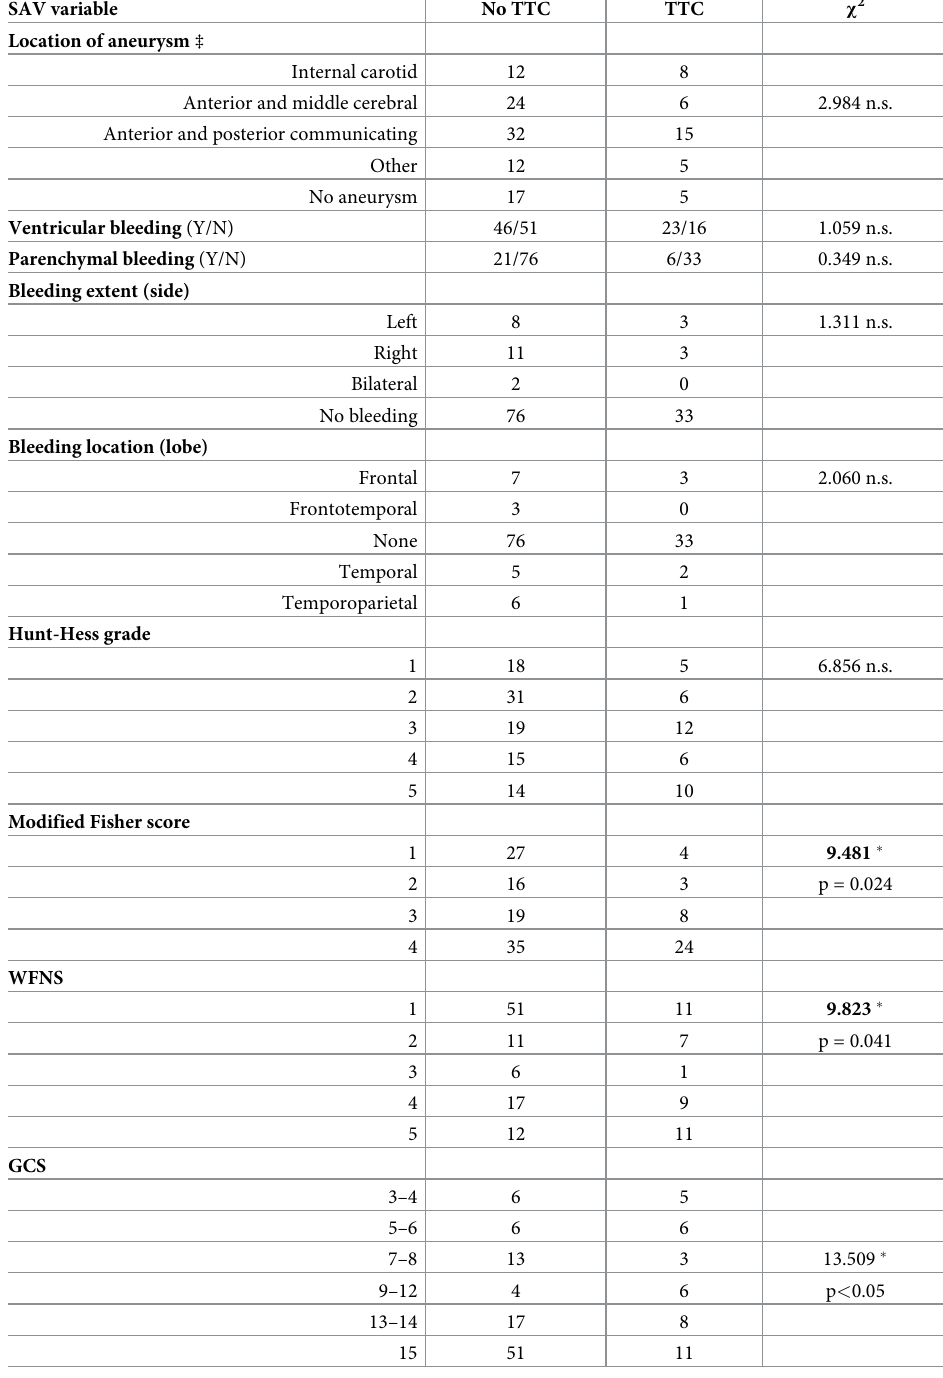
Table 3. Occurrence of TTC in SAV variable